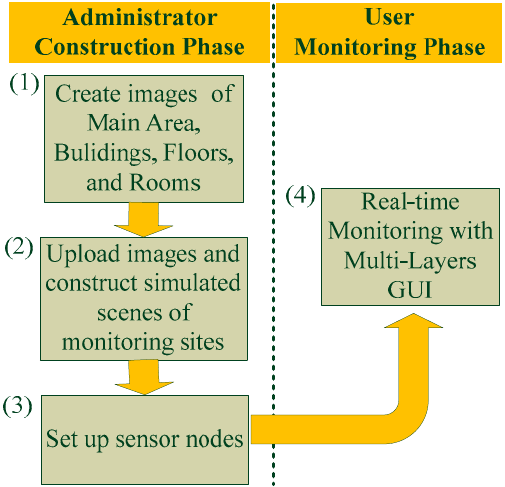
Figure 1. Overall architecture of the method to construct simulated monitoring GUI on demand.